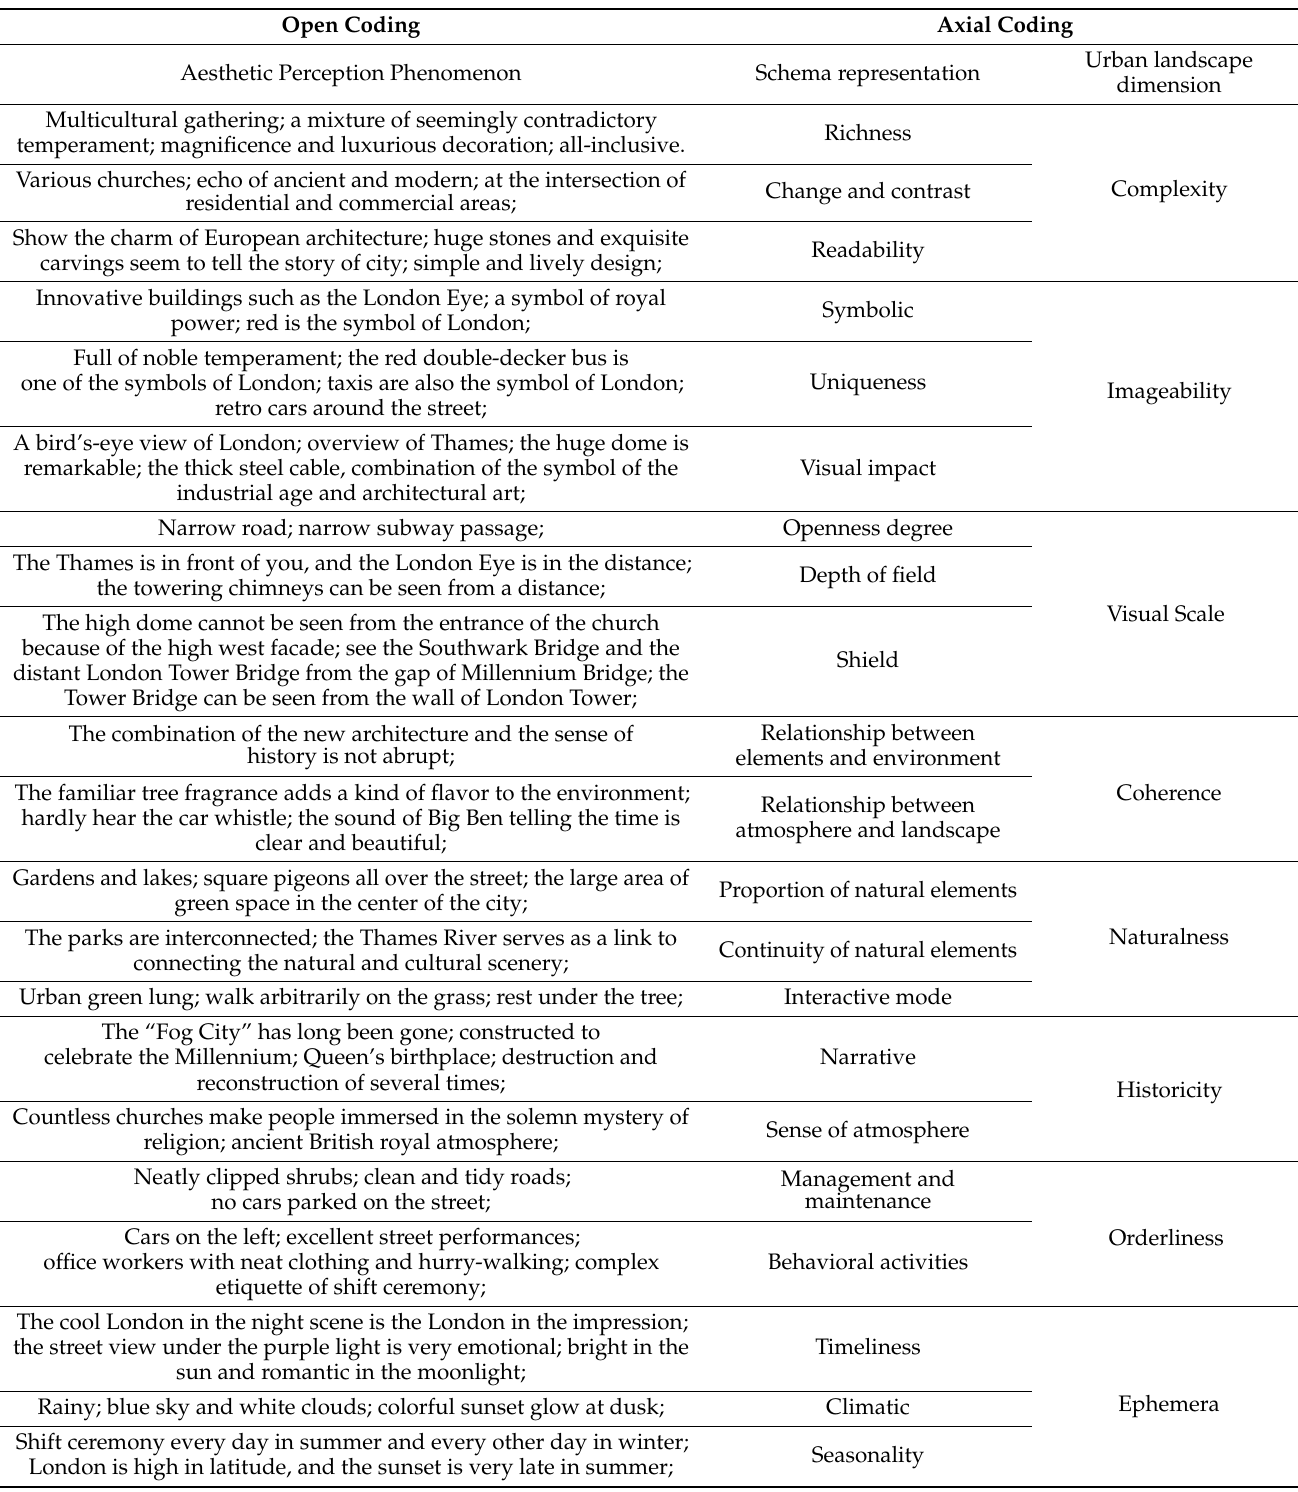
Table 3. Structure of Cognitive Schema of Urban